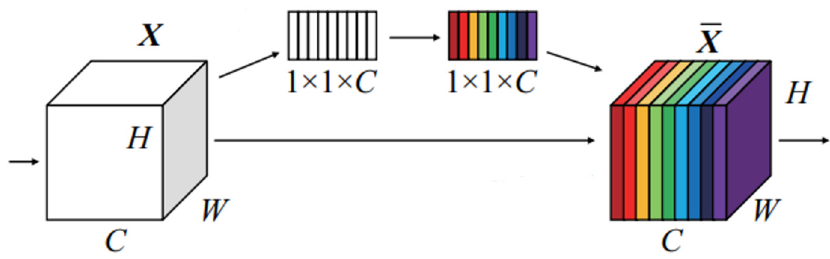
Figure 3. The squeeze-and-excitation network structure.